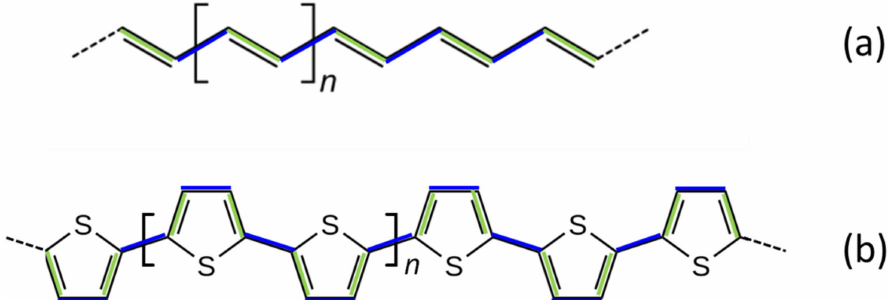
Scheme 1. Schematic illustration of the vibrational displacements associated with the collective ECC coordinate ( a ) for polyacetylene and ( b ) for polythiophene. Coloured segments are associated